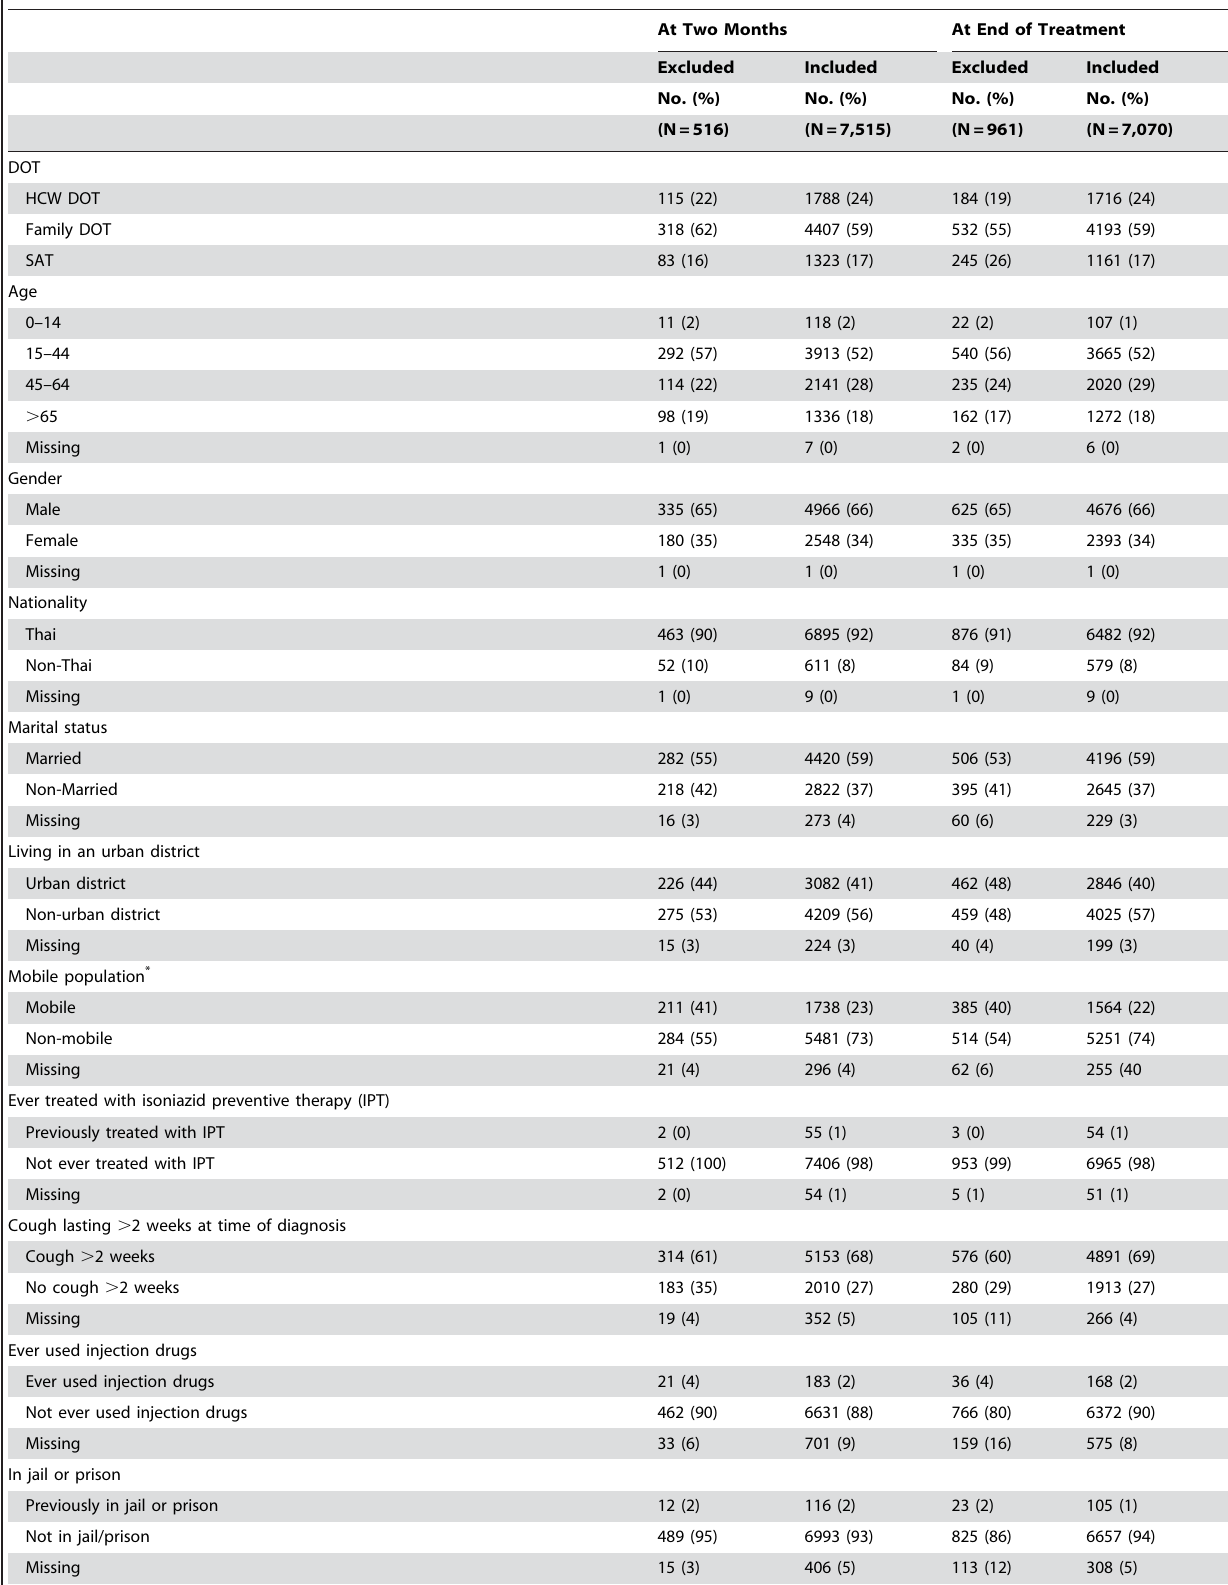
Table 2. Characteristics of eligible TB patients, stratified by inclusion or exclusion from two month and end of treatment analysis.